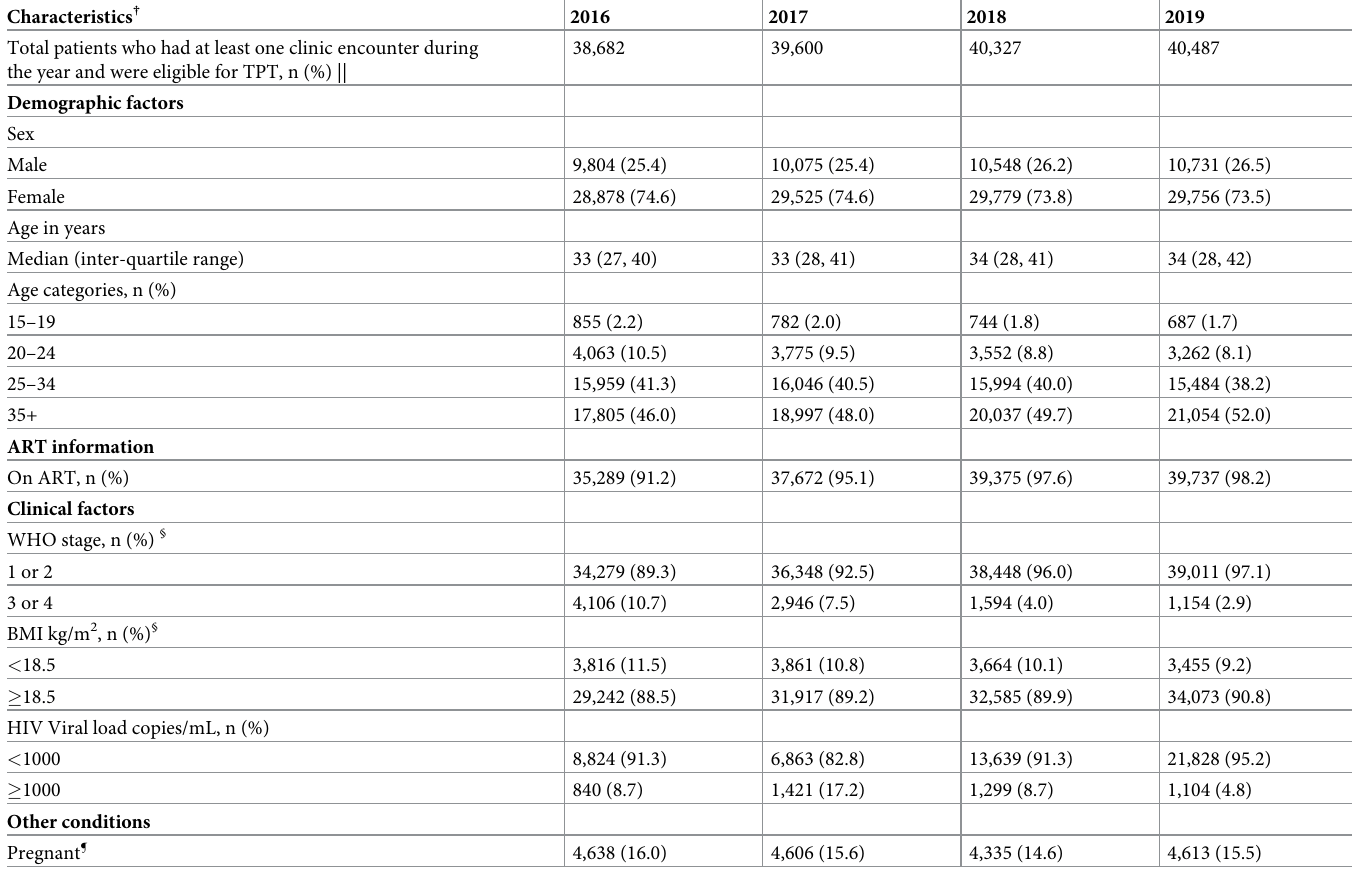
Table 1. Patients’ baseline characteristics at TPT uptake by